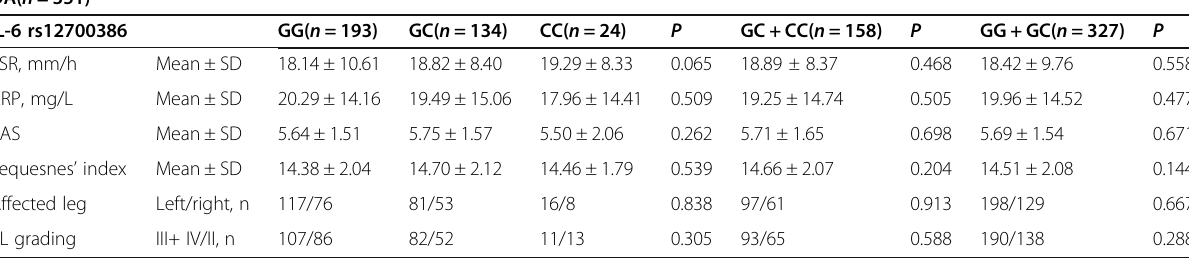
Table 4 Comparison of studied according to IL-6 genotypes in all osteoarthritis cases